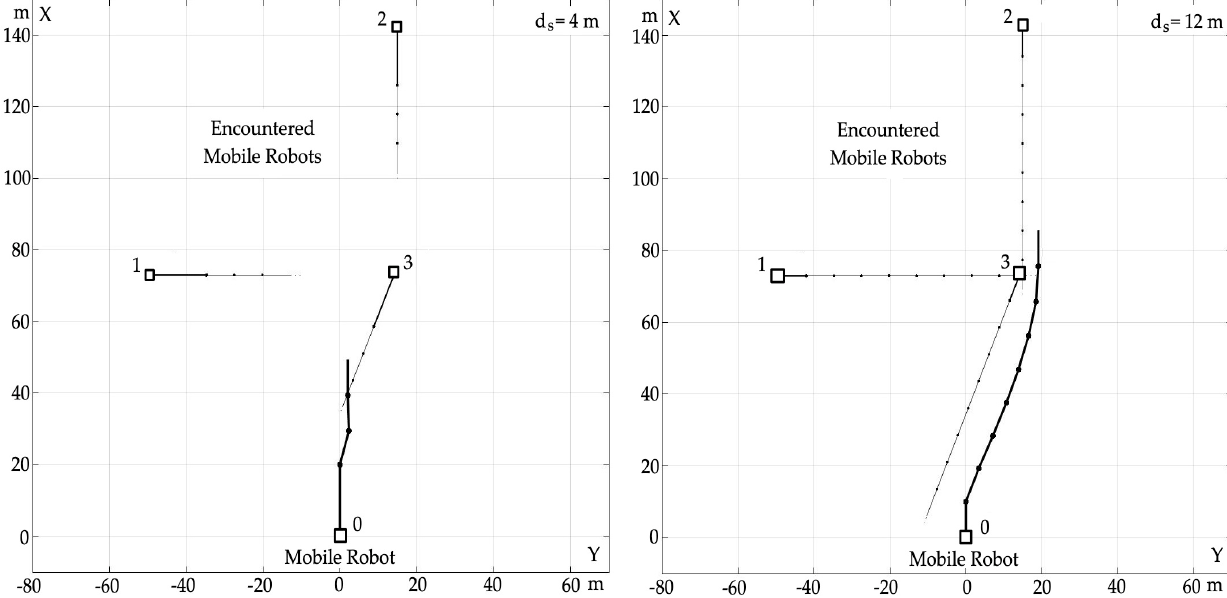
Figure 8. Mobile robot safe path when passing K = 3 encountered mobile robots in good weather conditions ( d s = 4 m) and in unfavorable weather conditions ( d s = 12 m), determined by the NG_oc algorithm of the non-game control.